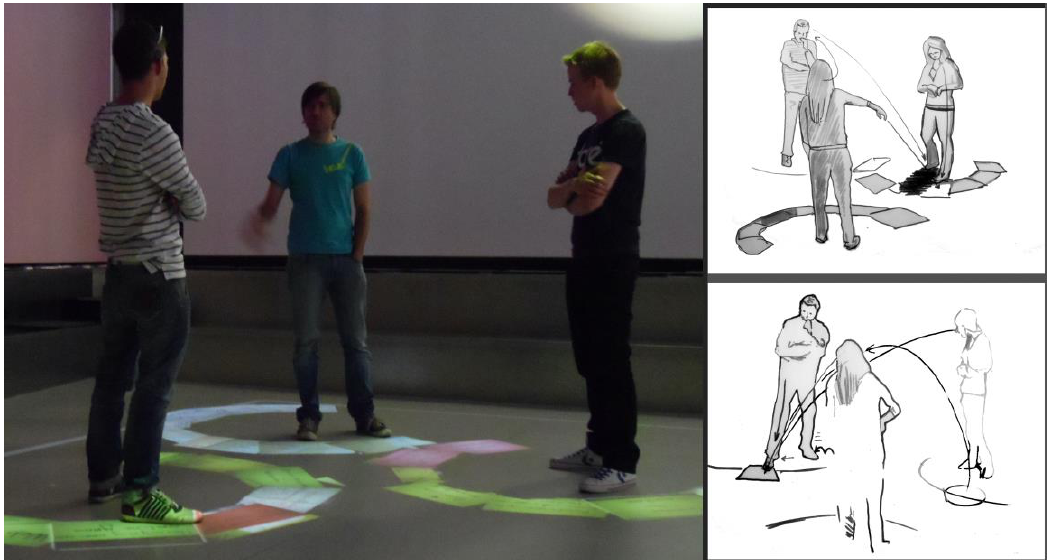
Figure 5. Floor-It prototype and example of qualitative analysis of Floor-It scaffolding participatory sense-making in social interaction. Details explained in text. Pictures taken from [71].